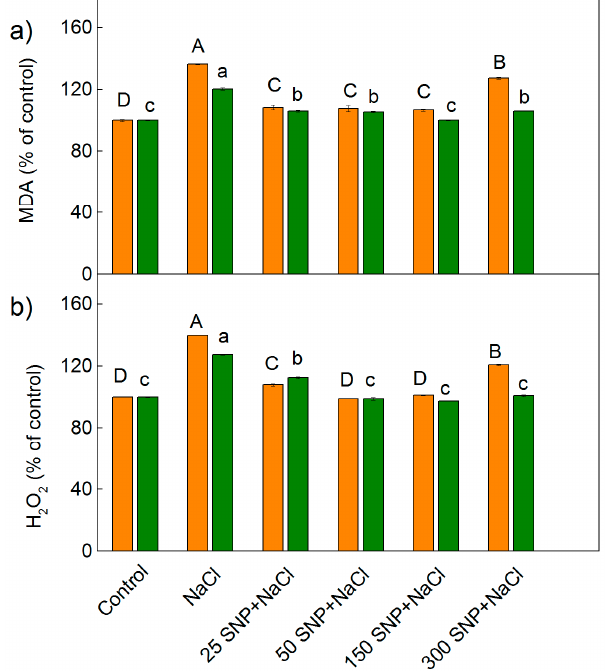
Figure 2. Effects of SNP on the content of MDA ( a ) and H 2 O 2 ( b ) in the leaves of two sorghum varieties (Albanus—orange bars and Shamal—green bars) under salt stress. The values are expressed as a percentage of the control (100%). Control values for Albanus are: MDA = 231.2 nmoles g − 1 DW, H 2 O 2 = 132.2 nmoles g − 1 DW; and for Shamal are: MDA = 167.0 nmoles g − 1 DW, H 2 O 2 = 109.6 nmoles g − 1 DW). Mean values (±SE) were calculated from eight independent measurements. The significant differences among treatments at p < 0.05 are indicated by different letters (uppercase for Albanus and lowercase for Shamal).